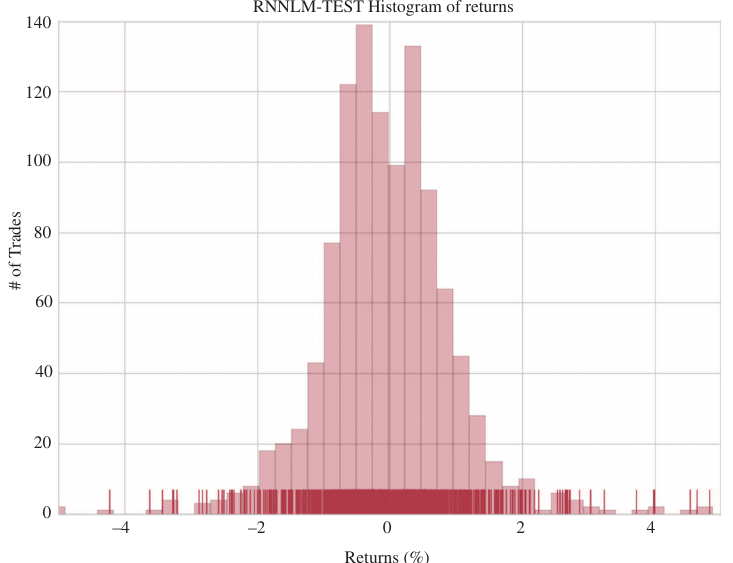
Figure 9: RNNLM Histogram of Percentage Returns Focused on Range ( − 5%, 5%).